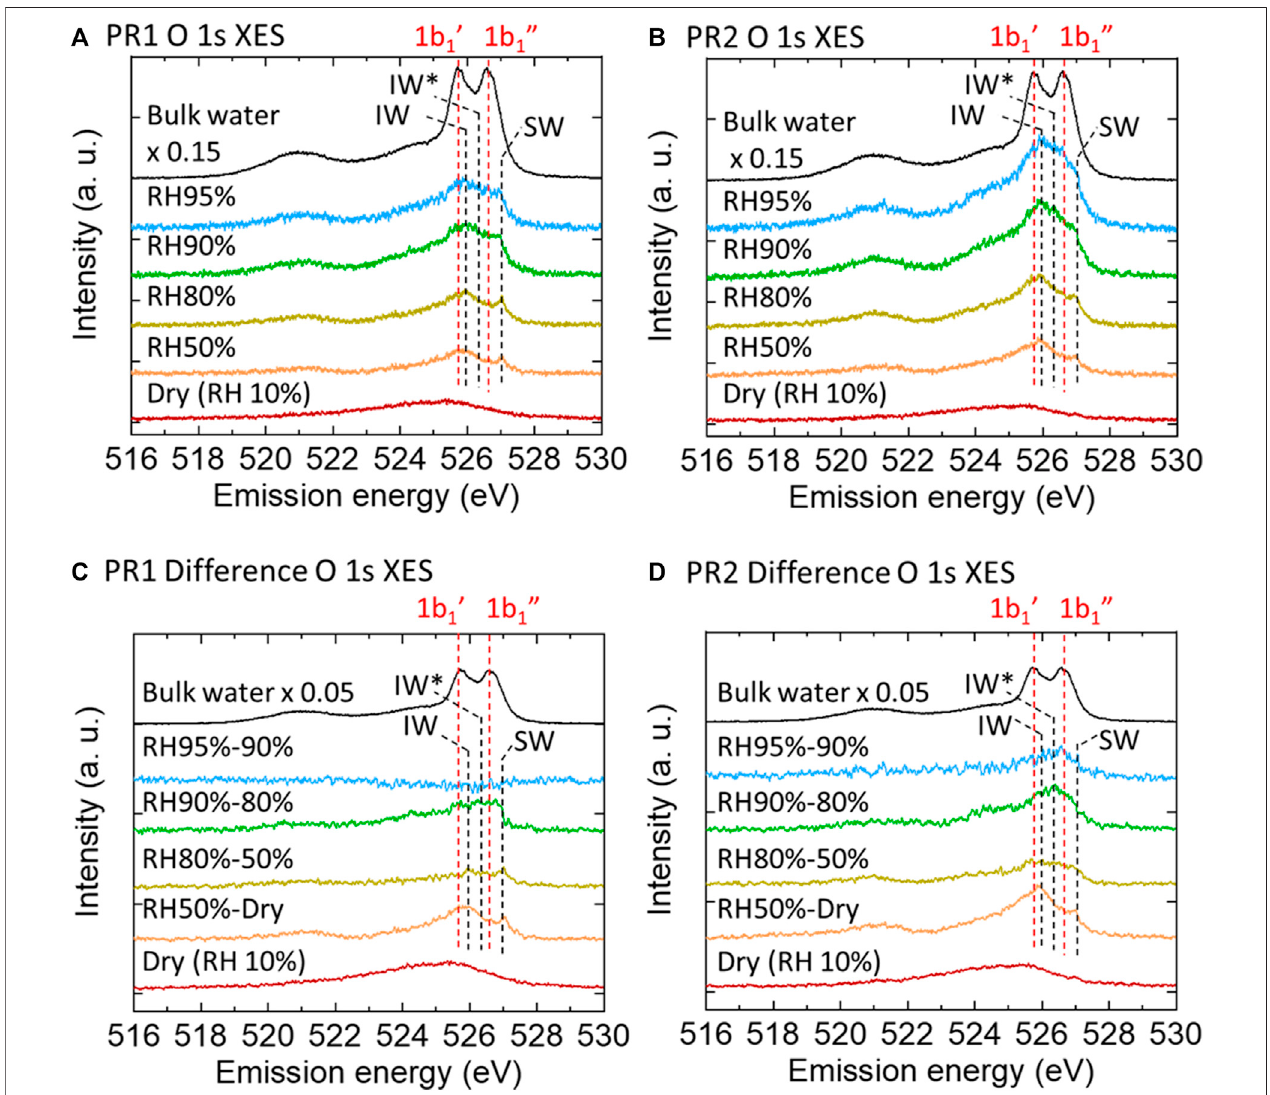
FIGURE 3 | O 1s XES spectra of PR1 (A) and PR2 (B) polyrotaxane polymer fi lms at various humidities obtained by subtracting the dry polymer spectra. Dry (RH 10%) and pure water spectra are the raw data. Each difference spectrum (C,D) was obtained by subtracting the neighboring lower-humidity spectrum.